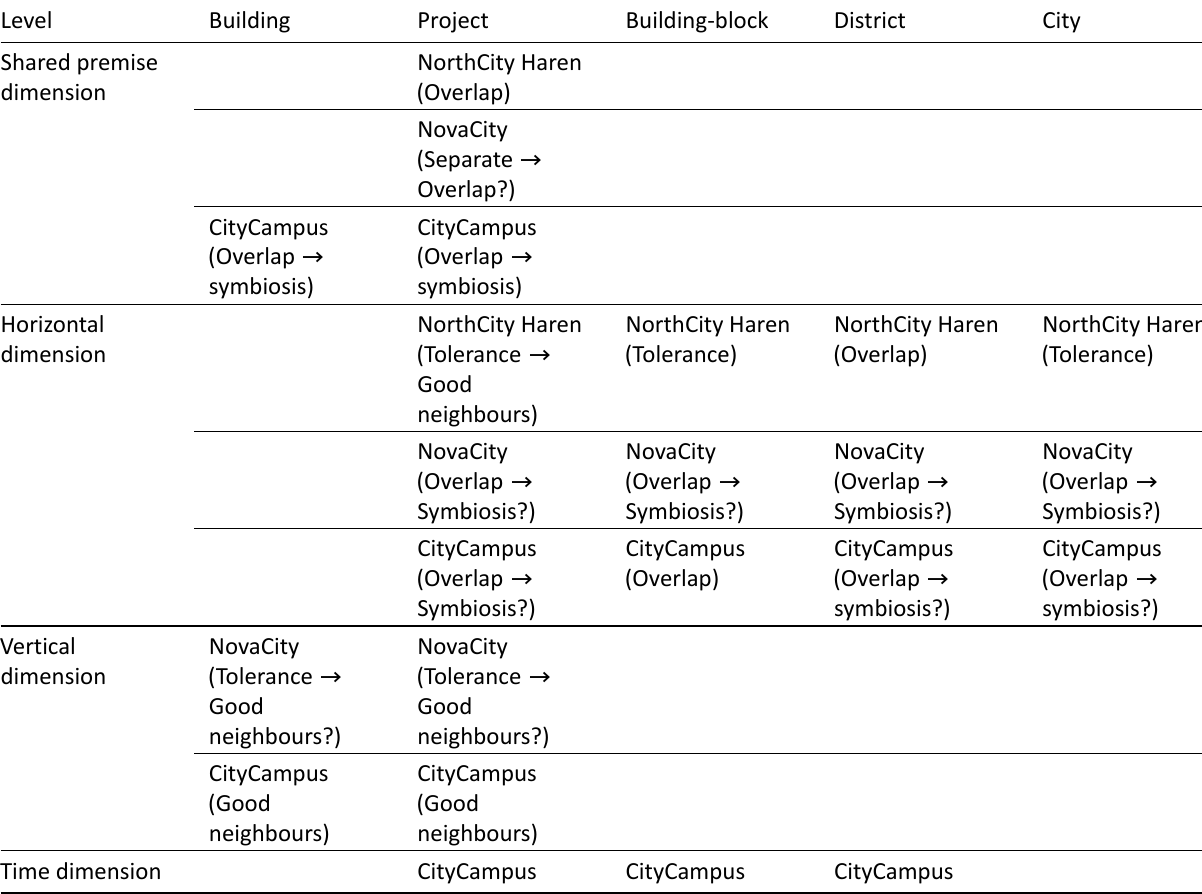
Table 5. Mixed land use according to the H–L scheme (Hoppenbrouwer & Louw, 2005) by dimensions and